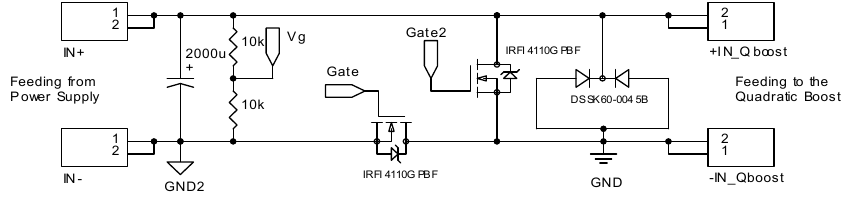
Figure 17. Power stage circuit of the Buck-switch cell.